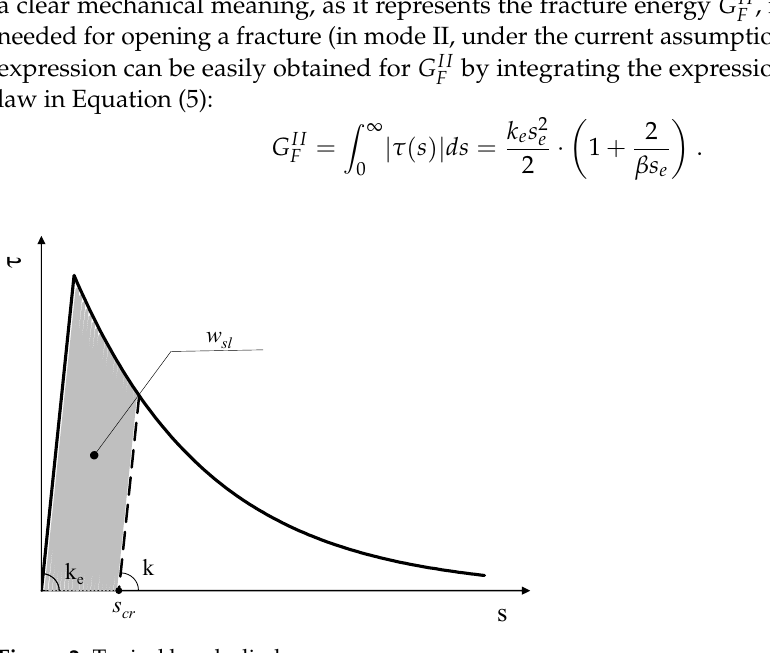
Figure 2. Typical bond–slip law.